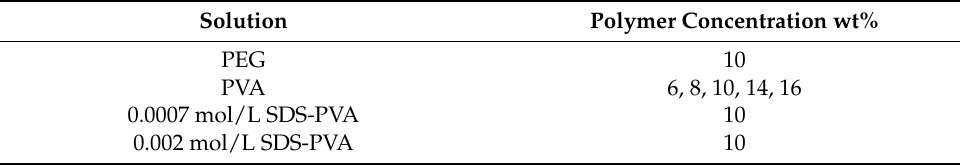
Table 2. Concentration of the measured aqueous